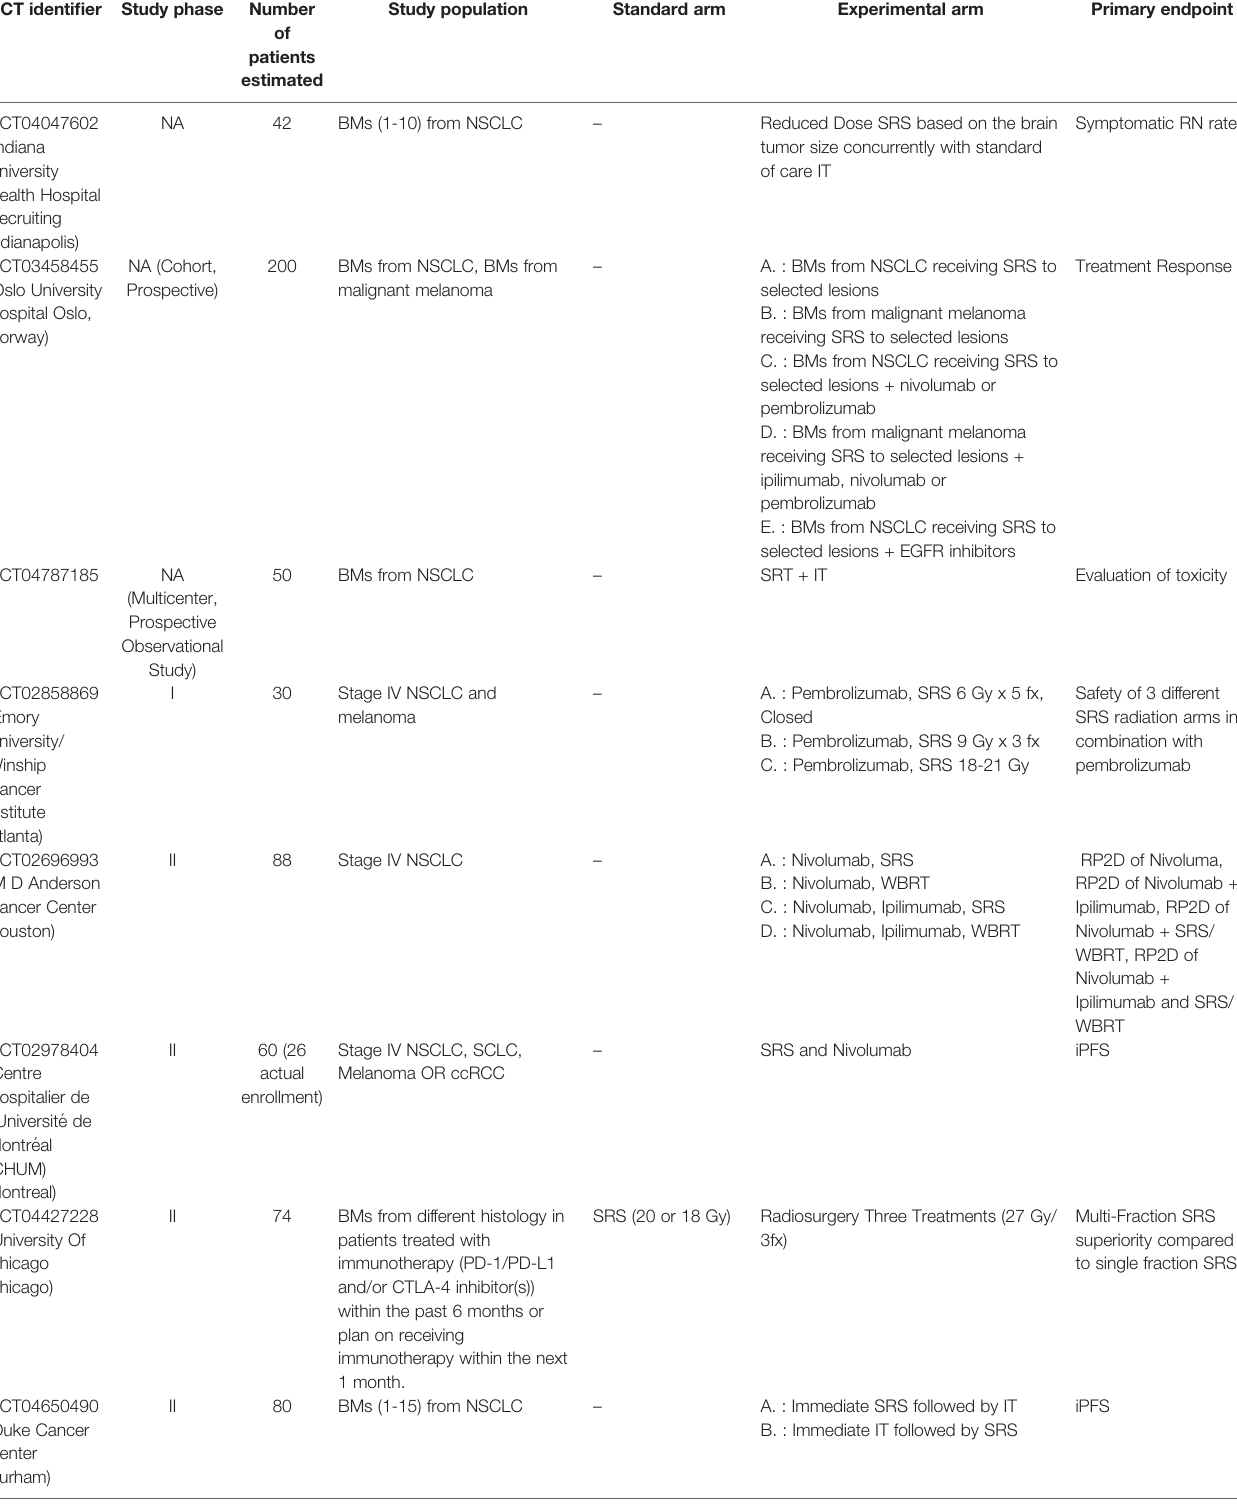
TABLE 5 | Selected ongoing clinical trials investigating the combination of Immunotherapy and